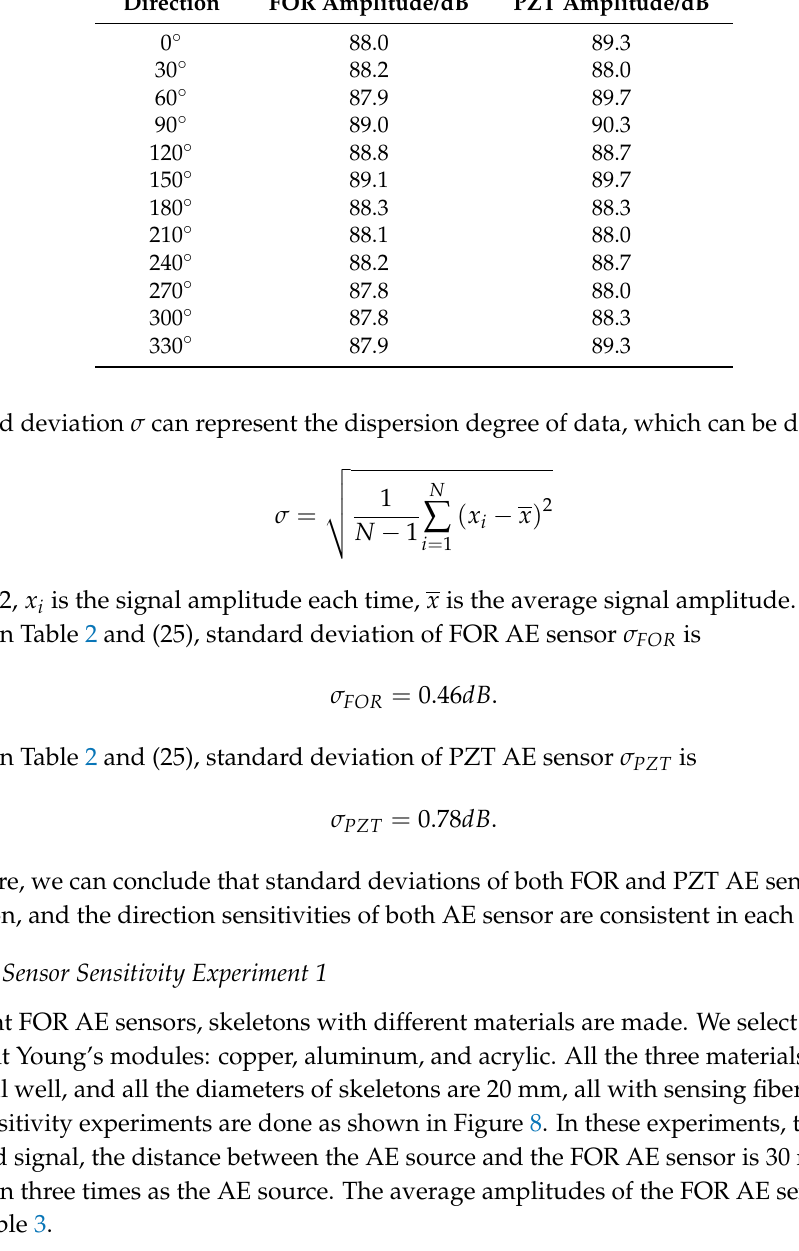
Table 2. Average amplitude of broken lead signal detected by FOR and PZT AE sensors. Direction FOR Amplitude/dB PZT Amplitude/dB 0 ◦ 88.0 89.3 30 ◦ 88.2 88.0